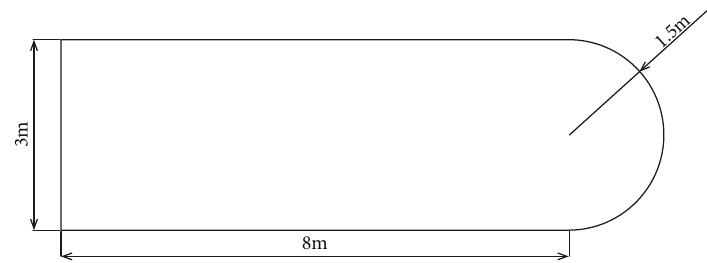
Figure 2: Geometric dimensions of the space habitat